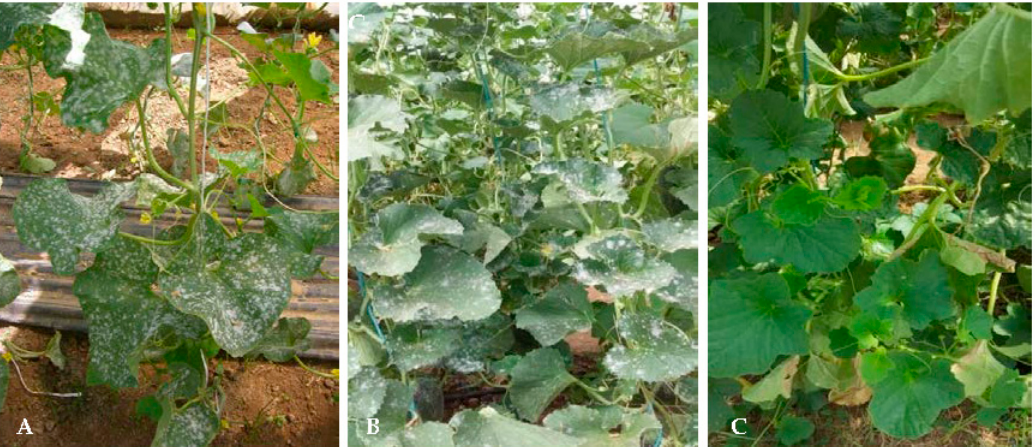
Figure 3. Assessment of Powdery mildew symptoms under natural infection. ( A ) ‘PMR-45 ′ and ( B ) ‘Bola de Oro’ (both accessions were susceptible to Race 2), ( C ) Resistant accession Tun-25 (Asli). Symptom evaluation was made when all plants of the susceptible accession showed severe symptoms of infection.